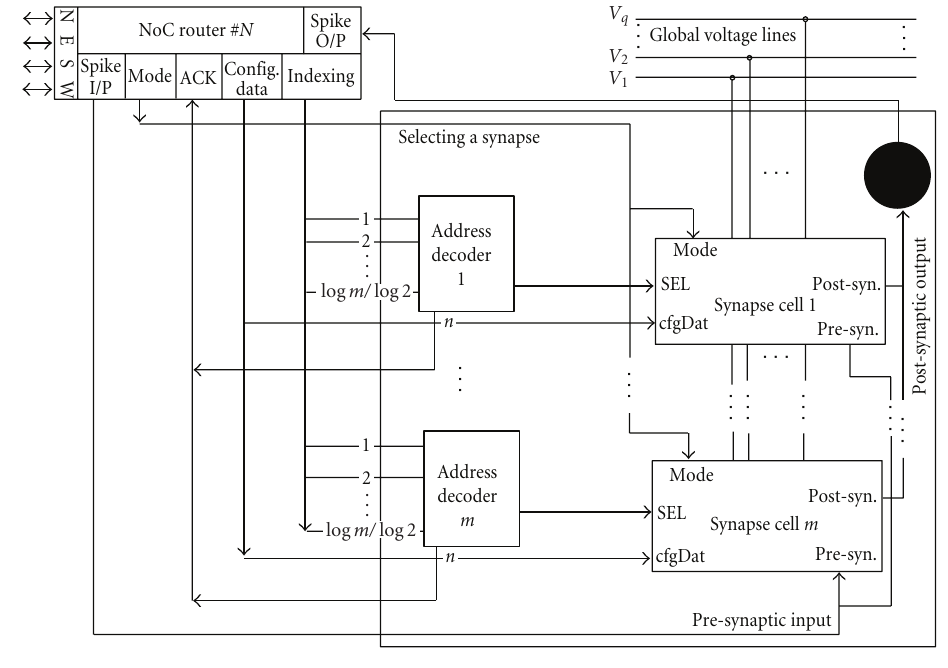
Figure 5: EMBRACE: neural tile structure.